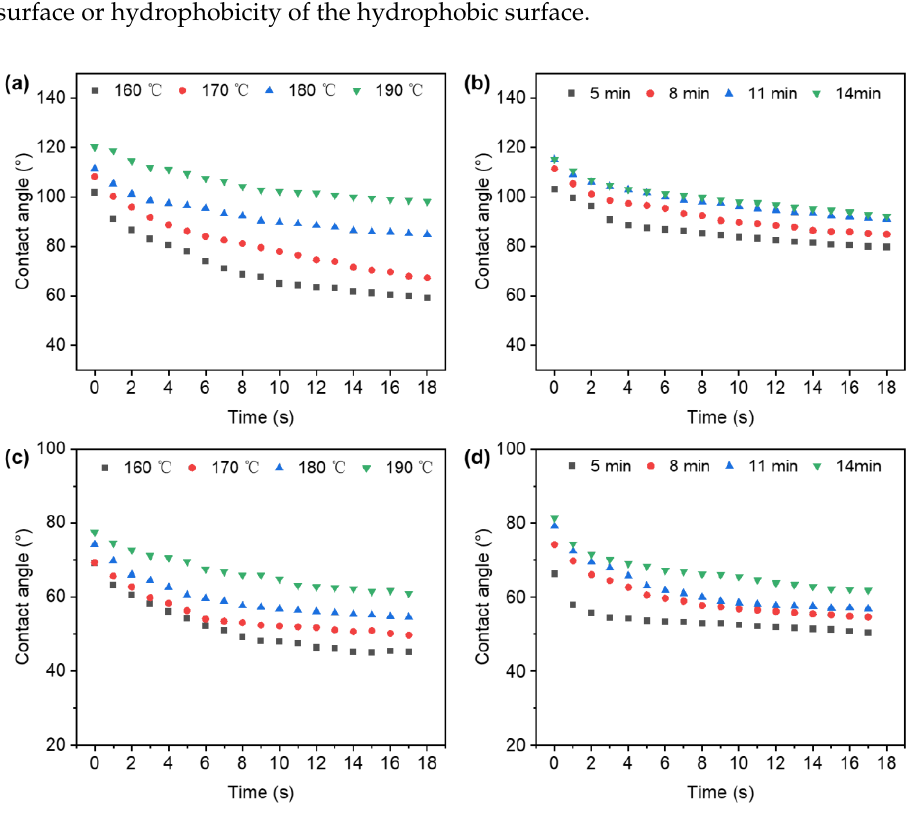
Figure 3. ( a ) Contact angles tested by water in the TPM-treated veneers at different temperatures; ( b ) contact angles tested by water in the TPM-treated veneers at different durations; ( c ) contact angles tested by PF resin in the TPM-treated veneers at different temperatures; and ( d ) contact angles tested by PF resin in the TPM-treated veneers at different durations.